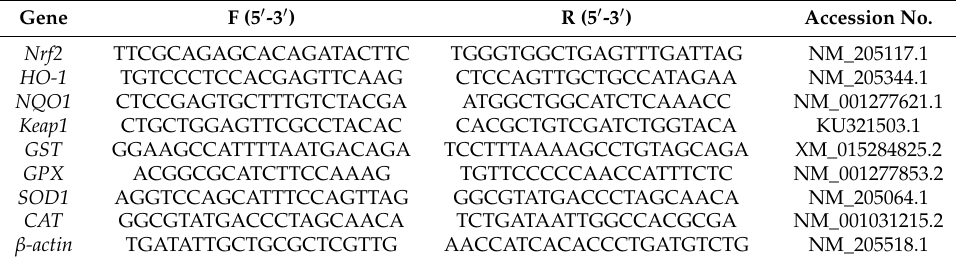
Table 2. Sequences of the primers used for the detection of gene expression levels.